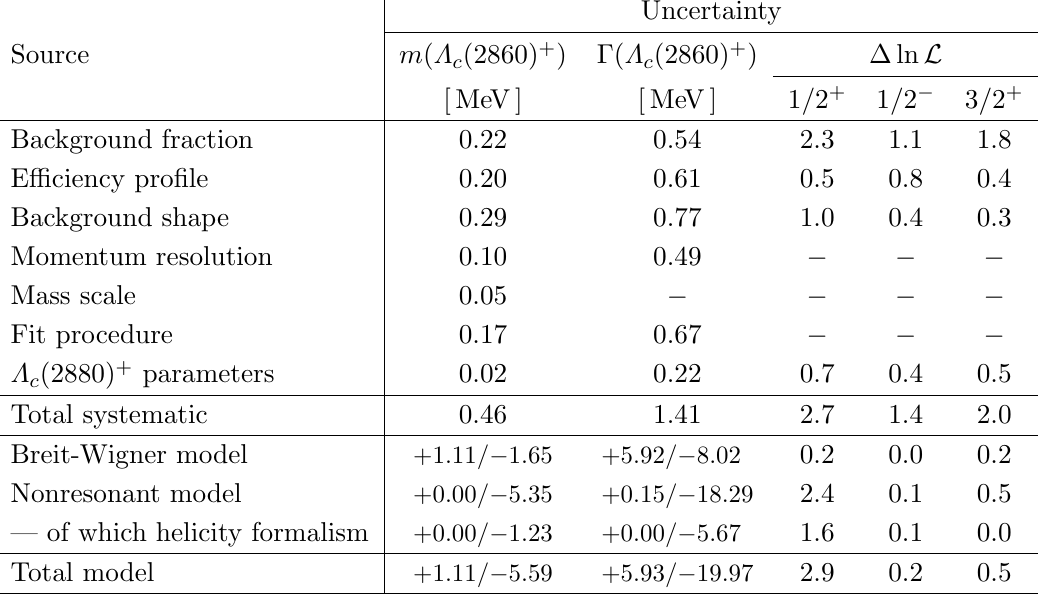
Table 6 . Systematic uncertainties on the (cid:3) c (2860) + parameters and on (cid:1) ln L between the baseline 3 = 2 + and alternative spin-parity assignments. The uncertainty due to the nonresonant model includes a component associated with the helicity formalism, which for comparison is given explicitly in the table,